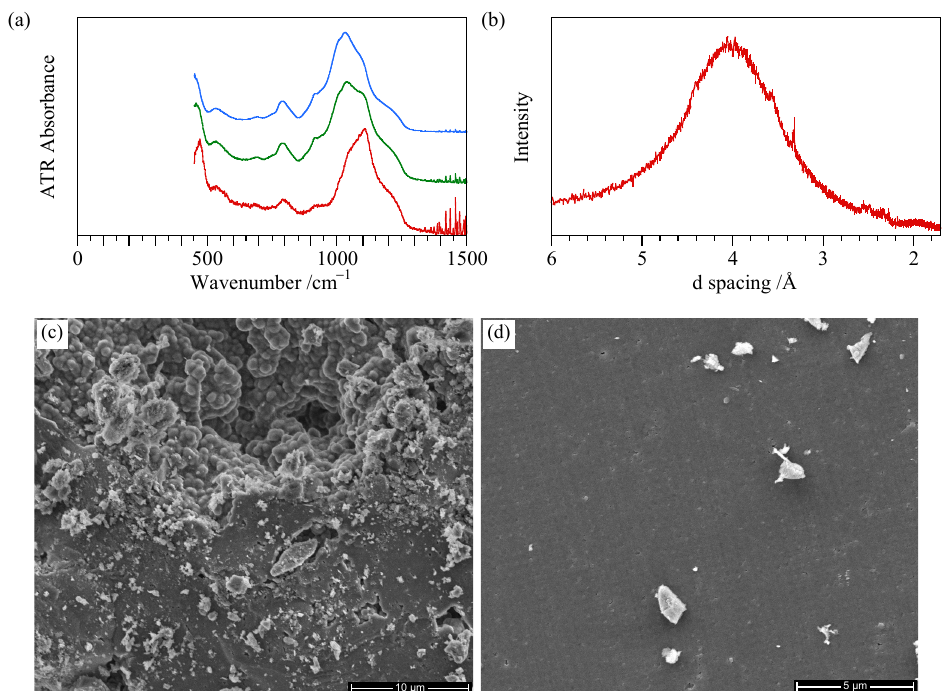
Figure A2. Spectra for G15584-AG (opal replacing wood from White Cliffs New South Wales, Australia ( a ) IR ATR spectra of progressively ground samples from the coarsest (red) to finest (blue), ( b ) XRD pattern (Co source), and ( c , d ) SEM images of different regions of a powdered sample. IR spectra are offset and scaled for convenience.